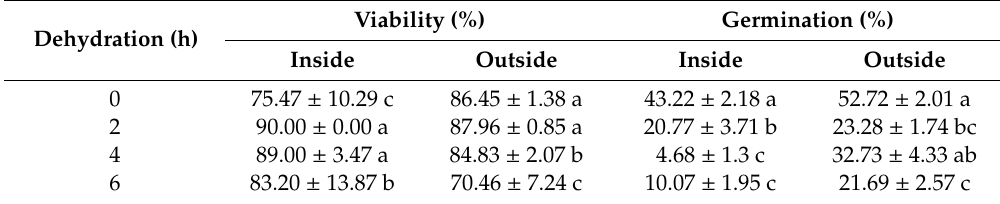
Table 2. E ff ect of dehydration in silica gel on the percentage of viability (A) and germination (B) of teak pollen germinated in BK medium at 10% of its salts + 10% sucrose and stained with 1% acetocarmine, analyzed inside and outside the